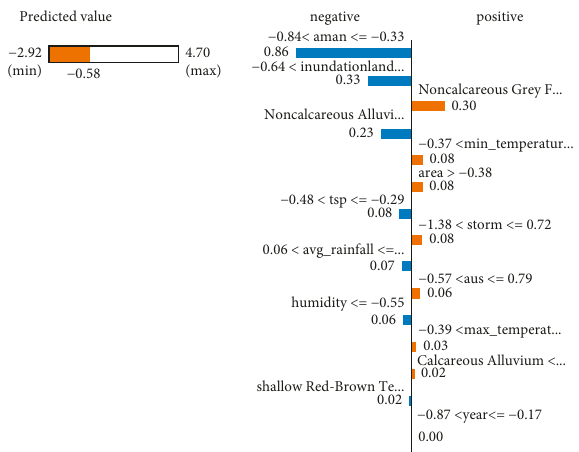
Figure 28: A plot of LIME model values for the SVR model and Boro yield data.